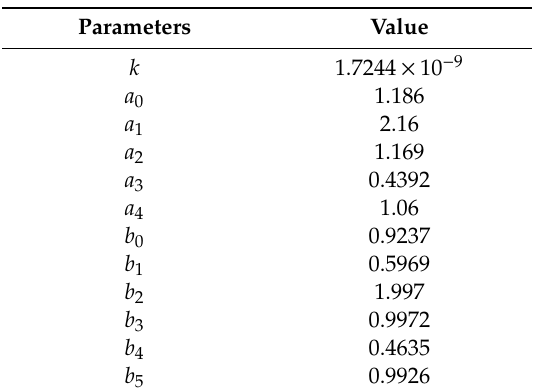
Table 2. Dynamics system parameter